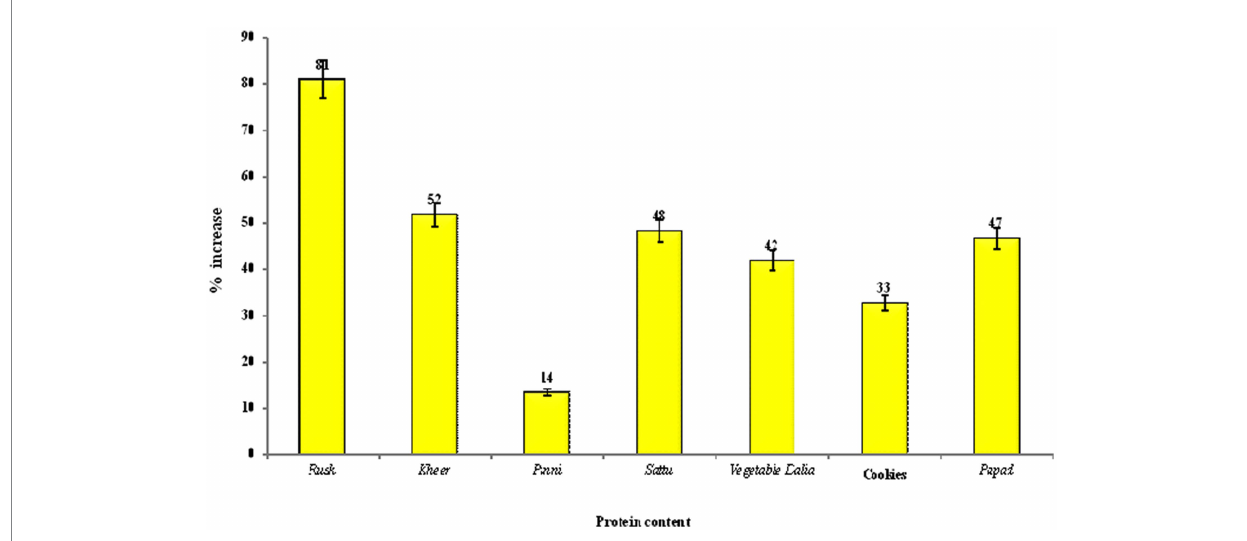
FIGURE 3 Percent increase in the protein content of the food products prepared from Foxtail millet with respect to control